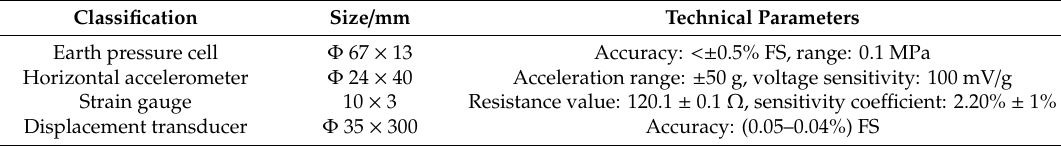
Figure 7. Loading steps.